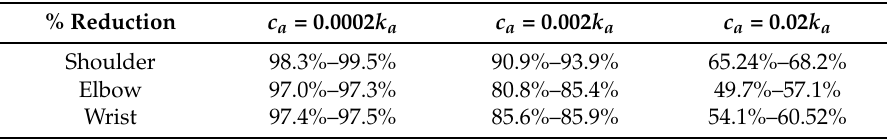
Table 6. Percentage of reduction in flexion motion at hand joints due to the “dual absorber” in the time